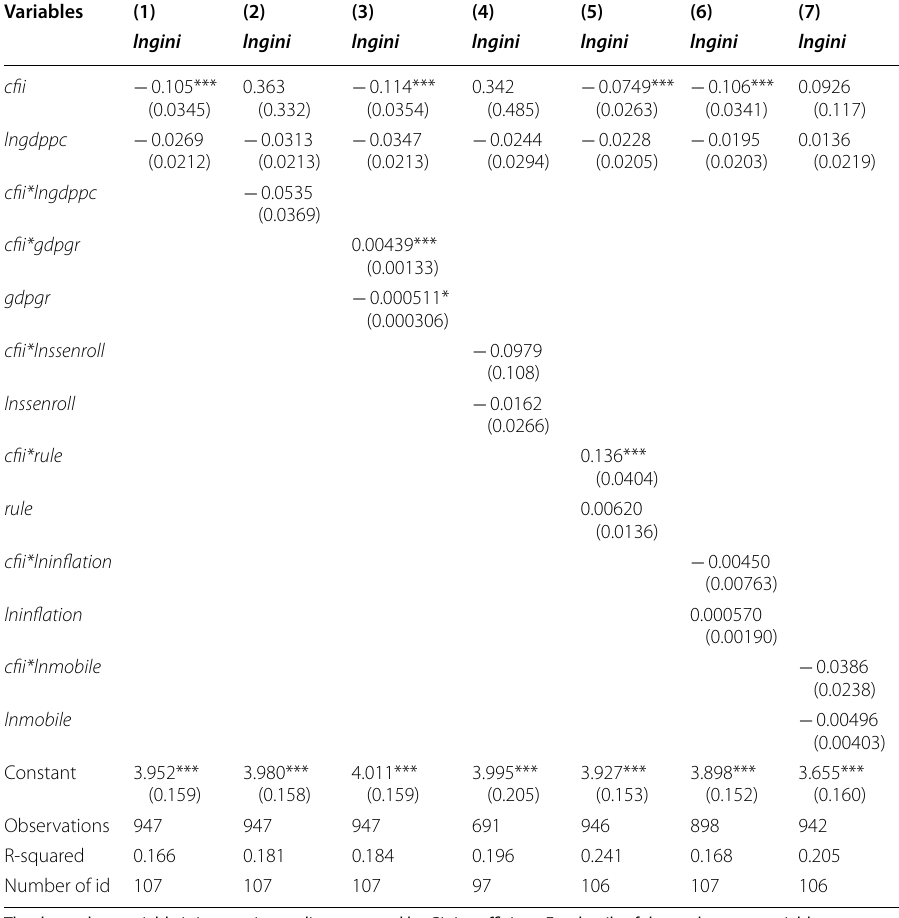
Table 6 Conditional effects of financial inclusion on income inequality (fixed effect